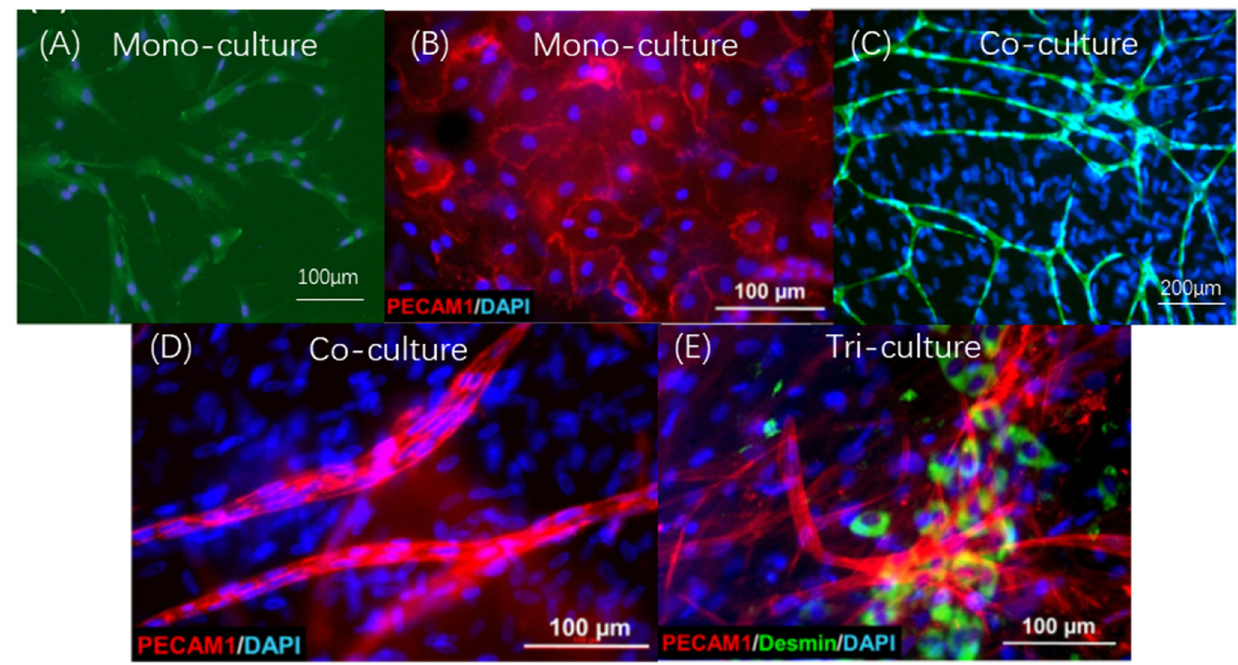
Figure 4. CPC-MF scaffold system and co-culture/tri-culture microenvironment system construction for bone regeneration. ( A ) hPDLSCs (second passage) were immunofluorescently stained with anti- STRO-1 antibodies (green) and 4 ′ ,6-diamidino-2-phenylindole (DAPI) for nuclei (blue). ( B ) Mono- cultured human umbilical vein endothelial cells (HUVECs) were immunofluorescently stained with endothelial marker platelet and endothelial cell adhesion molecule 1 (PECAM1; red) and DAPI for nuclei (blue) at day 15. ( C ) For the group co-cultured with HUVECs and hPDLSCs, vessel length/junctions were quantified. HUVECs were immunofluorescently stained with CD31 (green), and both HUVECs and hPDLSCs were stained with DAPI for nuclei (blue) at day 21. ( D ) Group co- cultured with hi-PMSCs and HUVECs. HUVECs were stained in red, and both nuclei were stained in blue. ( E ) Tri-culture group with hi-PMSCs, HUVECs, and pericytes. HUVECs were stained in red, pericytes were stained for the specific marker desmin in green, and all nuclei were stained in blue. (Adapted from references [9,28,37], with permission). 4. Effect of Metformin on Dental-Derived Stem Cells PDLSCs originate from the periodontal ligament and are the most well-known stem cells in bone tissue engineering. PDLSCs are also known for their triple differentiation potential: PDLSCs can differentiate into not only an osteogenic lineage but also into fibro- genic and cementogenic lineages to regenerate the periodontal complex [39] (Figure 5). In bone tissue engineering, when seeding on different scaffolds, such as CPC or pol- ydopamine-templated hydroxyapatite (tHA), PDLSCs could interact with metformin and exert different effects. CPC scaffolds have nearly the same mechanical characters as can- cellous bone and can upregulate PDLSC osteogenic expression [9,47]. The scaffold tHA could induce apoptosis by producing reactive oxygen species (ROS). However, when combined with metformin, tHA notably decreases ROS production, enhances the level of microtubule-associated protein 1 light-chain 3 II and BECLIN-1 and eliminates cell injury and apoptosis, resulting in increased seed cell osteogenic gene expression. Similarly, met- formin activates AMPK signaling pathways in the scaffolds despite their different up- stream or downstream regulations. Moreover, PDLSCs could differentiate into fibrogenic lineages. Studies showed that metformin could regulate the fibrogenic cytokine trans- forming growth factor beta (TGF- β ), representing a well-designed cascade treatment for cancer [48]. In conclusion, as an important family of target stem cells, hPDLSCs, have ex- cellent differentiation potential in bone tissue regeneration.